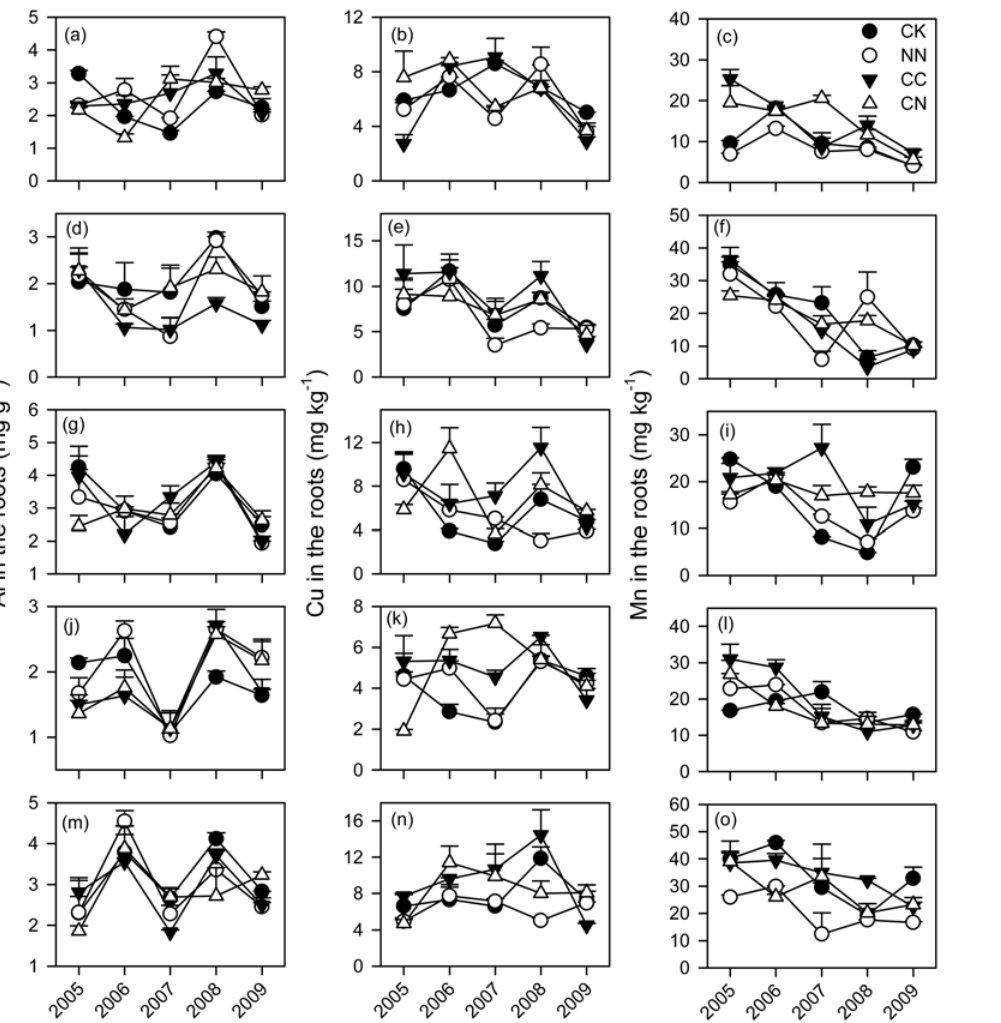
Fig 4. Concentrations of metal cations in the roots of five subtropical tree species exposed to different CO 2 and N treatments from 2005 to 2009. Each error bar is one standard error. CK, control; NN, ambient CO 2 with N fertilizer; CC, elevated CO 2 without N fertilizer; CN, elevated CO 2 with N fertilizer. (a-c) A . acuminatissima ; (d-f) S . hancei ; (g-i) C . hystrix ; (j-l) O . pinnata ; (m-o) S . superba